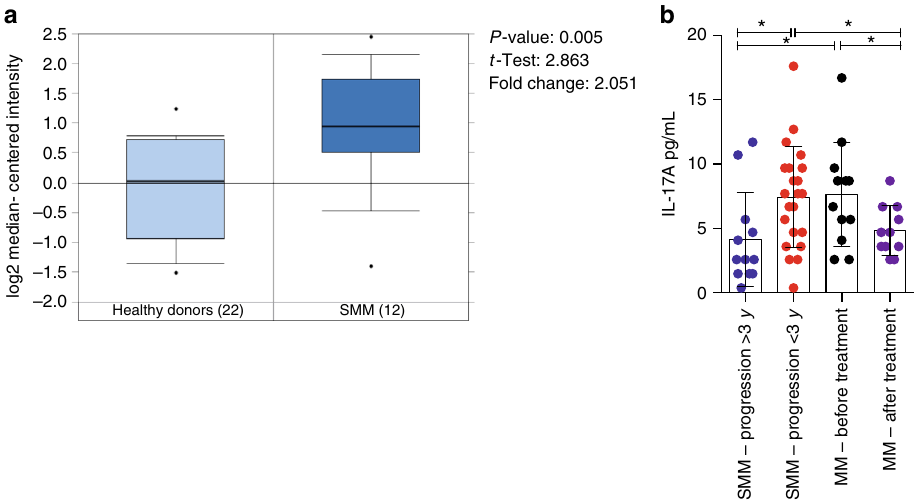
Fig. 4 IL-17 levels are increased in the BM of SMM patients rapidly progressing to MM. a mRNA expression of IL-17RA in primary SMM cells of a cohort of 12 newly-diagnosed patients and 22 matched controls (bone marrow) described in ref. 65 . The expression pattern for the probe set 205707_at is shown. Statistical analysis (Student t test) is reported. b IL-17 levels in the BM plasma of SMM patients that progressed to MM within 3 years since the diagnosis (i.e., <3 years), or did not progress to MM in the same time frame (i.e., >3 years). Each dot represents an individual patient. (SMM-Progression > 3 n = 12, SMM-Progression < 3 n = 22, MM-Before treatment n = 12, MM-After treatment n = 11). Data are reported as mean ± SD. Unpaired t test: * P <